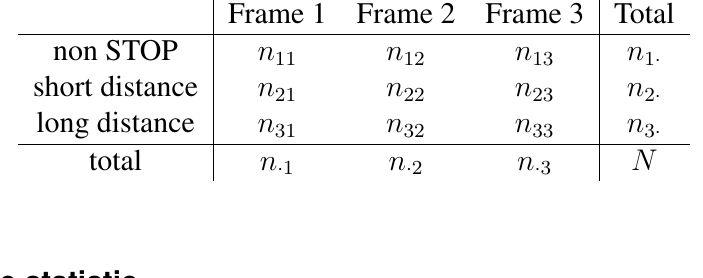
Table 1: Contingency table for each window. Note: n · 1 = n · 2 = n · 3 = w and n 1 j = w − n 2 j − n 3 j